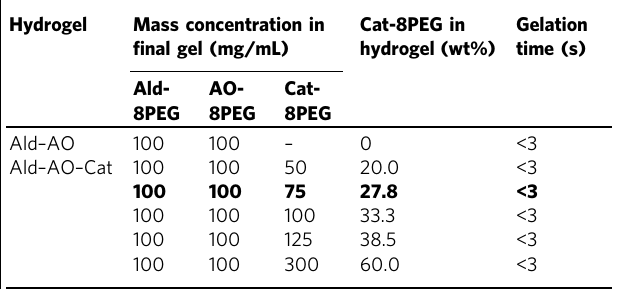
Table 2 Hydrogel formulations.